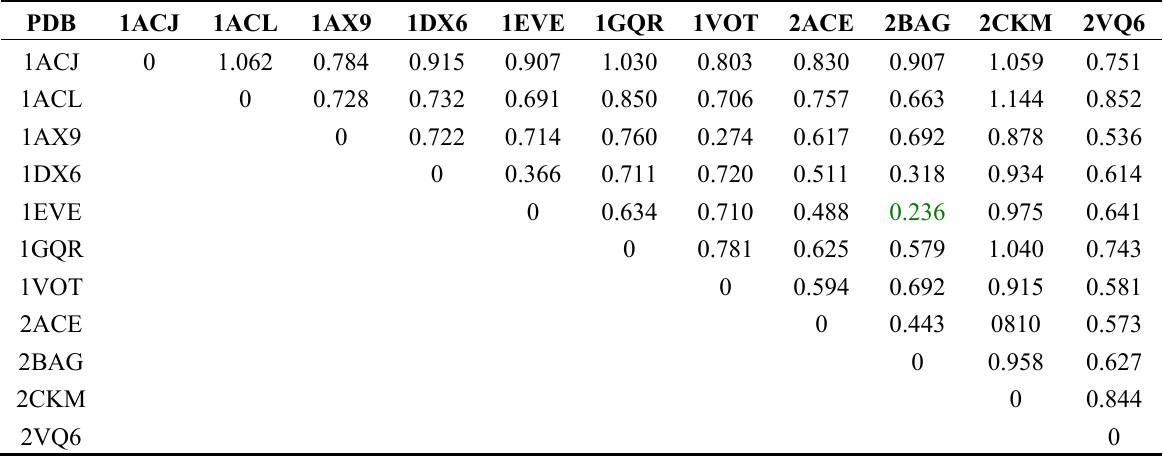
Table 1. Comparison of the TcAChE active site from different crystal complexes from the PDB: root-mean-square deviation (rmsd) values in Å for all atoms: the amino acids included in the comparison are presented in Figure